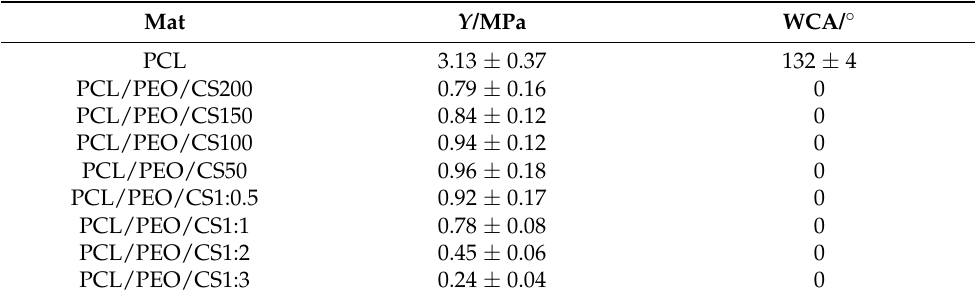
Table 2. Values of mechanical properties (Young’s modulus, Y ) and water contact angle (WCA) of PCL electrospun mats with and without CS